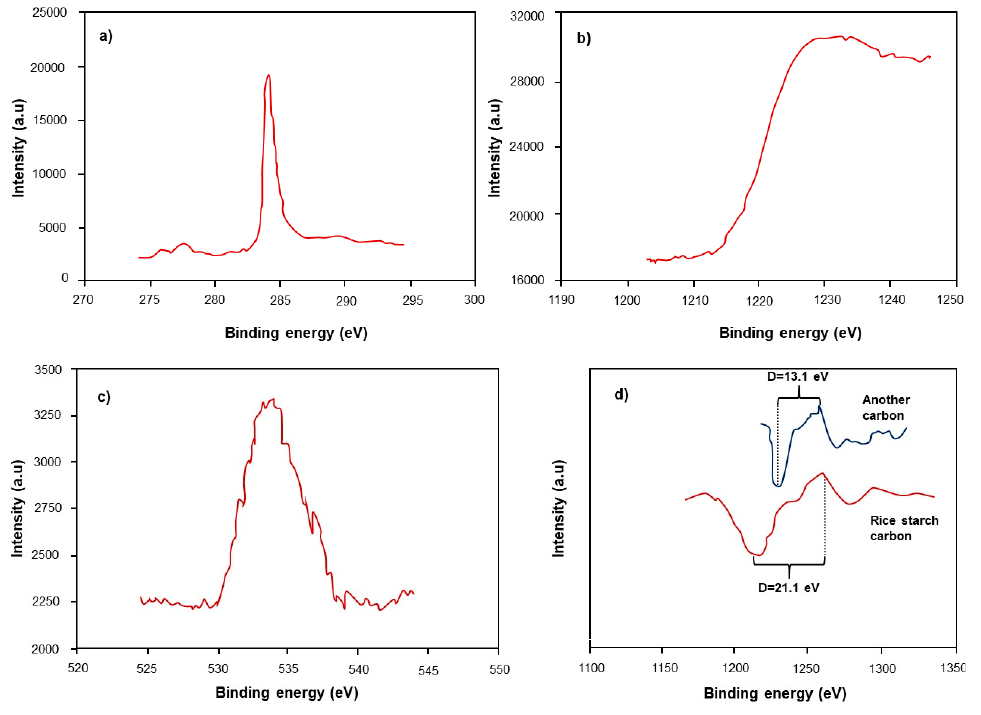
Figure 8. XPS analysis of carbon obtained from rice starch: ( a ) C 1s spectrum peak position: 284.8 eV; ( b ) high binding energy featured at approximately 290 eV; ( c ) O 1s spectrum peak position: 532.8 eV and ( d ) D-parameter for the rice starch carbon compared to another carbon.